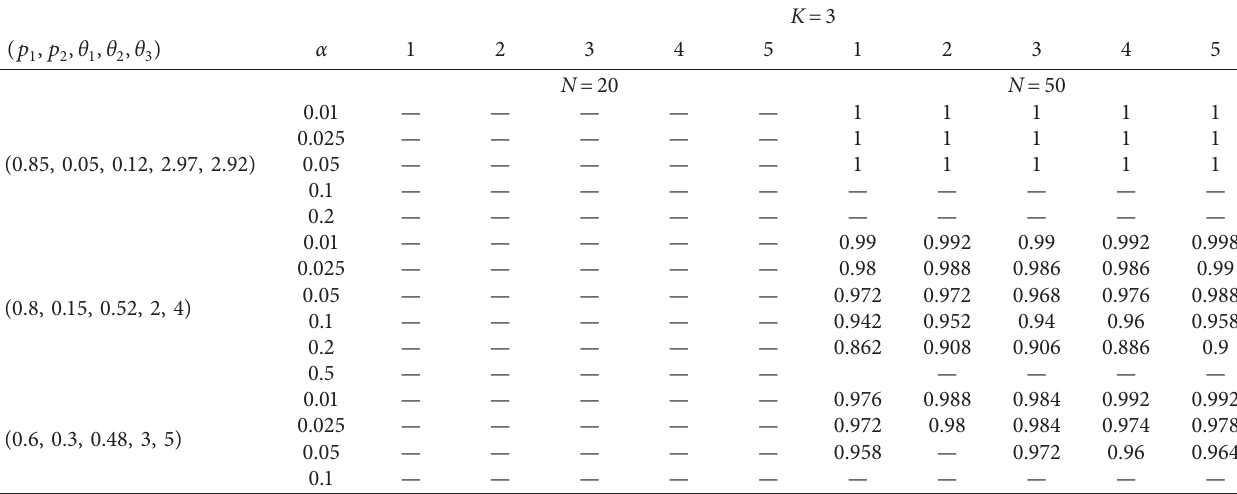
Table 5: Power results for estimated number of finite exponential components at k � 3.